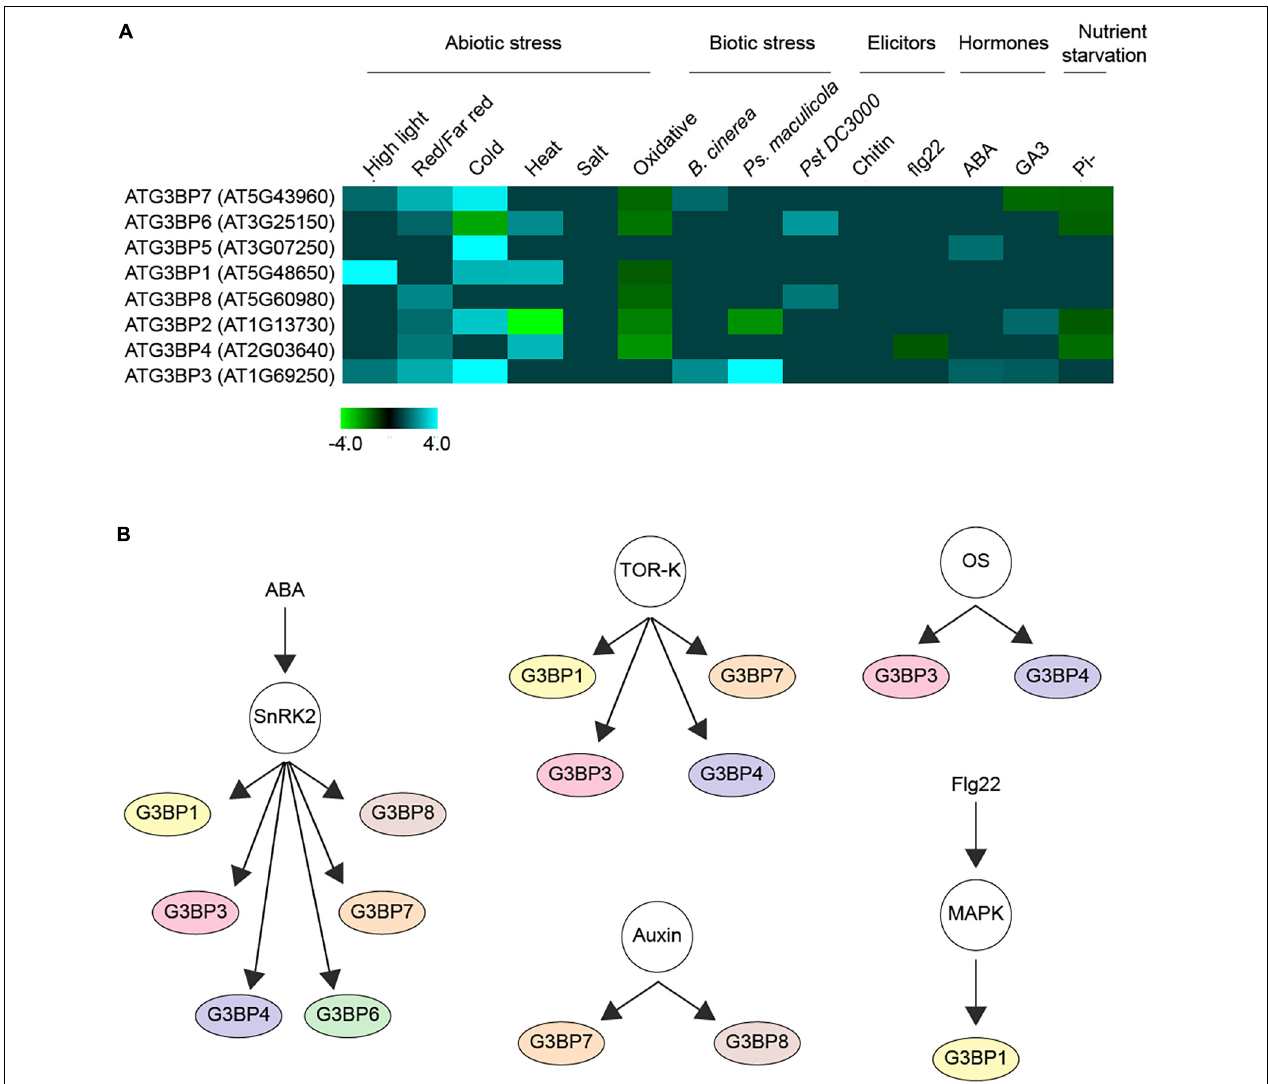
FIGURE 2 | Regulation of G3BPs. (A) a heatmap showing the induction or repression (log2 Fold change > ± 1) of the different G3BPs by various abiotic or biotic stresses, elicitors (such as chitin, flg22), hormones (such as ABA, GA3) and nutrient starvation. (B) G3BPs are reported as phospho-proteins in several large scale phosphoproteomics studies. The networks show the phosphorylation of different G3BPs under different condition. ABA treatment activates the kinase SnRK2, which inturn phosphorylates several substrates including G3BPs. The TOR-kinase also phosphorylates some G3BPs, so does osmotic stress (OS), auxin treatment or flg22 treatment. All this analysis was carried out using the PhosPhAT database and